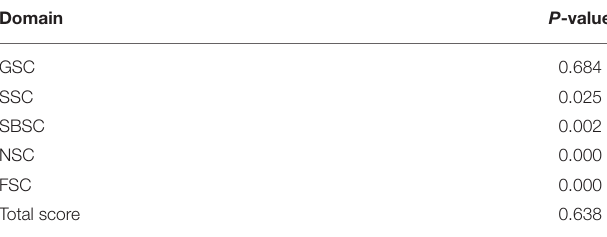
Statistical significance at 0.05 level.